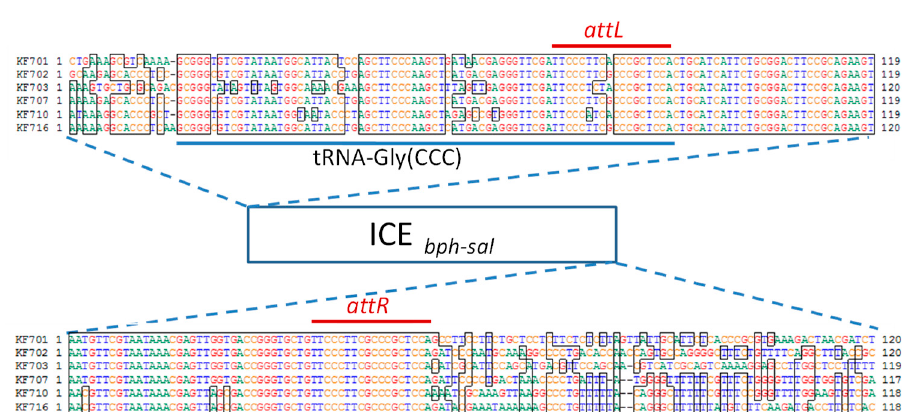
Figure 7. Integration sites of ICE bph-sal in the KF strains of group I and KF701 of group II. The attL (18 bp) site, including 18 bp of the 3’ end of tRNA-Gly gene, and attR (18 bp) sites are